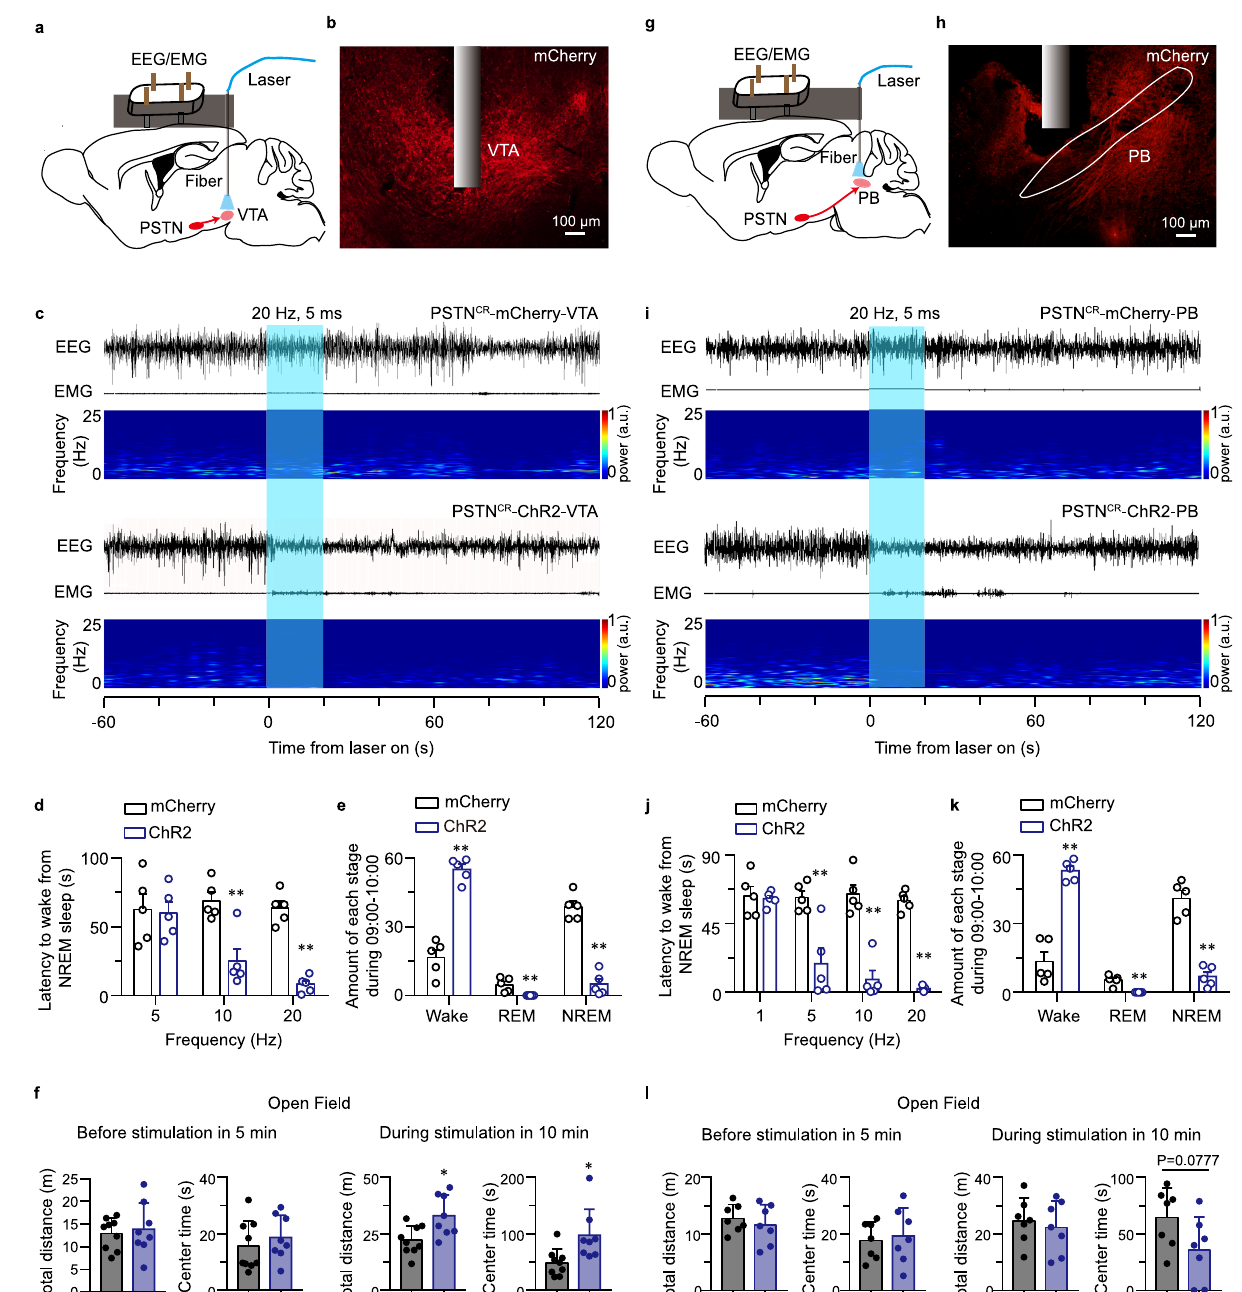
Fig. 4 | Optogenetic activation of the PSTN CR -VTA pathway induces a rapid photostimulation of the PSTN-VTA ( n =5, Wake: t 8 =9.366, P =1.38×10 − 5 ; REM: P =0.0081;NREM: t P =9.2×10 − 6 )( e )andPSTN-PB( n =5,Wake: t transition from NREM sleep to wakefulness and increases exploratory beha- 8 =3.496, 8 =9.893, P =2.28×10; − 5 REM: t P =7.93×10 − 4 ; NREM: t t viors. a , g Schematic of the optical stimulation in the VTA ( a ) and PB ( g ). 8 =8.748, 8 =5.23, 8 =8.716, P =2.34×10 − 5 ) ( k ) circuits. f There was no signi fi cant difference between the b , h Representative photomicrographs of the VTA ( b ) and PB ( h ) depicting ChR2- mCherry group and the ChR2 group in the locomotion and center time in the OF mCherry-positive terminals (red) from the PSTN. Scale bar: 1mm. c , i Representative EEG/EMG traces and corresponding heatmap of EEG power test (left) before light on. The locomotion and center time are signi fi cantly increasedintheChR2groupduring10minafterphotostimulationoftheVTA(5ms spectra illustrating the behavioral responses to optogenetic activation in PSTN CR - mCherry (up)/ChR2 (down)-VTA ( c ) and PSTN CR -mCherry (up)/ChR2 (down)-PB ( i ) blue light pulses at 20Hz for 30s, every 1min for 10min) (mCherry group: n =9, mice during the 3min recording. Blue columns indicate the photostimulation ChR2 group: n =8; Total distance: t 15 =2.888, P =0.0113; Center time: t 15 =2.791, P =0.0137). l There was no signi fi cant difference between the mCherry group and period(20s). d , j LatenciesofthetransitionsfromNREMsleeptowakefulnessafter the ChR2 group in the locomotion and center time in the OF test (left) before and photostimulation of the VTA projections ( n =5, 5Hz: t 8 =0.1909, P =0.8533;10Hz: P =0.0035; 20Hz: t P =1.16×10 − 5 ) ( d ) and PB projections ( n =5, t afterphotostimulation of the PB,the photostimulation conditions are the same as 8 =4.09, 8 =9.585, 1Hz: t 8 =0.2864, P =0.7818; 5Hz: t 8 =3.965, P =4.15×10 − 3 ; 10Hz: t 8 =6.534, ( f ) (mCherry or ChR2 group: n =7, Total distance: t 12 =0.4907, P =0.6325; Center P =6.08×10 − 8 ) ( j ) from the PSTN at different fre- P =1.81×10 − 4 ; 20Hz: t time: t 12 =1.929, P =0.0777). Unpaired two-sided t-test was used for statistical 8 =19.01, quencies. e , k Total amounts of each stage in mCherry and ChR2 group after analysis ( d – f , j – l ). Data represent mean±SEM, * P <0.05, ** P <0.01.